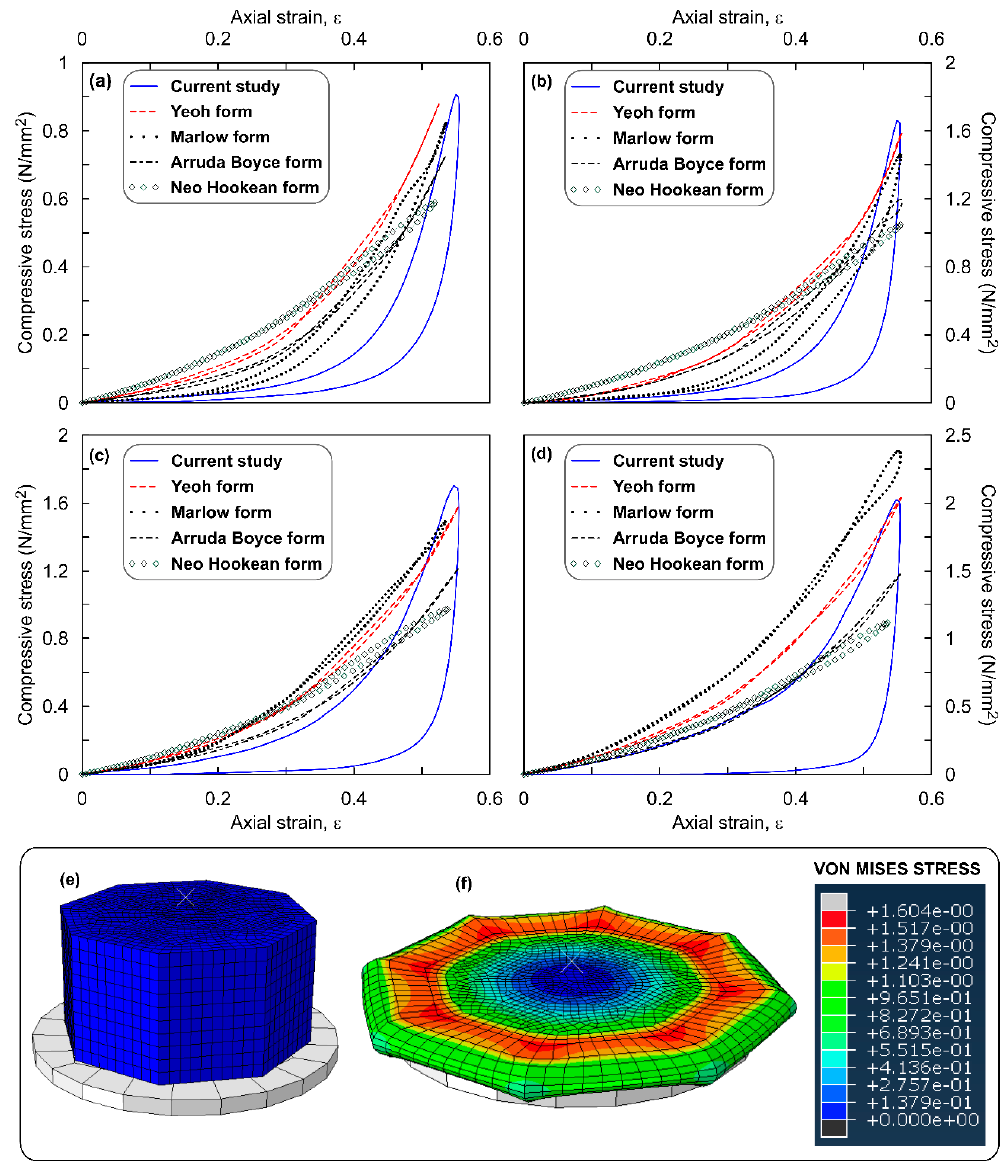
Figure 7. Cyclic stress strain response of Octagonal samples: ( a ) 0% OPS; ( b ) 5% OPS; ( c ) 10% OPS; ( d ) 20% OPS; ( e ) un-deformed model; ( f ) deformed model with stress contours at ε ≈ 50%.